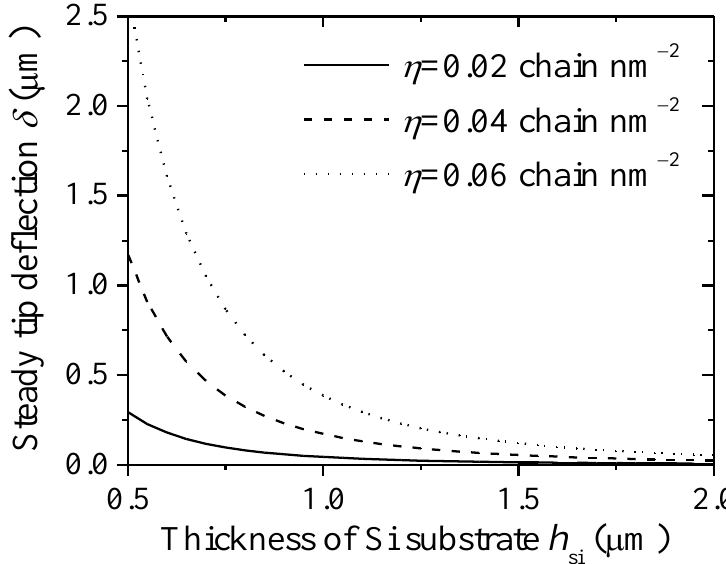
Figure 5. Steady tip deflection of a DNA-microcantilever sensor as a function of thickness of Si substrate under different grafting densities.